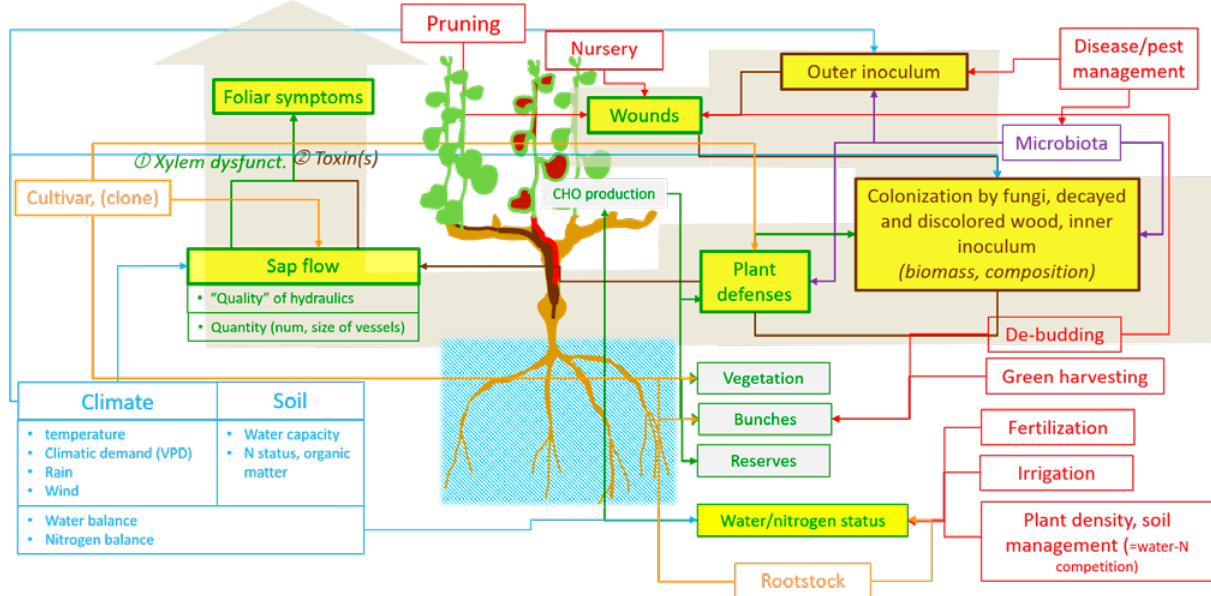
Figure 3. Conceptual model of GTDs based on the hypothetical sequence of events and adding major drivers of the system. GTD-associ- ated fungi are part of the microbiota and account for outer and inner inoculum. They enter vines through wounds, at many possible stages during the vine lifetimes, co-existing and interacting at the reaction zones. Because they are wood inhabiting fungi that alter wood (where storage and sap flow take place), because defences are needed, and because FS can alter vine physiology, global source/sink relationships need to be considered as indirect drivers in this approach. Grapevine/fungi relationships are modulated by microbiota and environmental conditions during each growing season and during vine lifetimes. These multiple combinations result in occasional outbursts of foliar symp- toms contributing to vine decline and death. The modulating factors belong to different categories: relations inside the microbiota (indicate in purple), climate and soil (blue), scion and rootstock genotypes (orange), cultural practices (red), that impact wound production and infection or grapevine physiology. A single factor can impact different parts of the sequence, aggravating the complexity. This conceptual model needs to be validated. N = Nitrogen, VPD = vapor pressure deficit, CHO = Carbon, Hydrogen, Oxygen (C